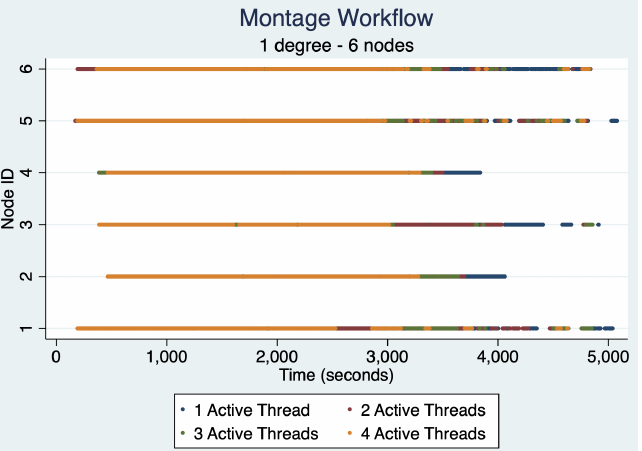
Figure 18. Number of Active Threads per node for a Montage 1.0 degree workflow on 6 cluster nodes. For both figures, usage of all 4 threads is indicated by ‘orange’ dot and usage of 3 threads is indicated by ‘green’ dot. ‘red ’ and ‘blue’ colored dots are used to indicate usage of two and one threads, respectively. The y-axis denotes the individual node and the x-axis the timestamp at any given instant. The analysis only considers the jobs which were executed on the nodes and not the local jobs such as file/folder creation, file transfers,